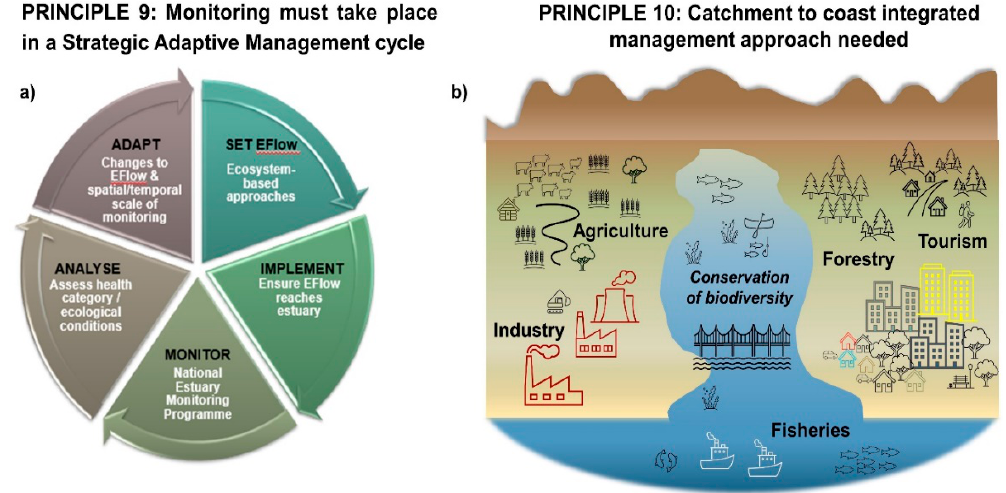
Figure 12. ( a ) The Strategic Adaptive Management cycle for the implementation of EFlows and compliance monitoring, and ( b ) Sectors involved in a catchment-to-coast integrated management approach.